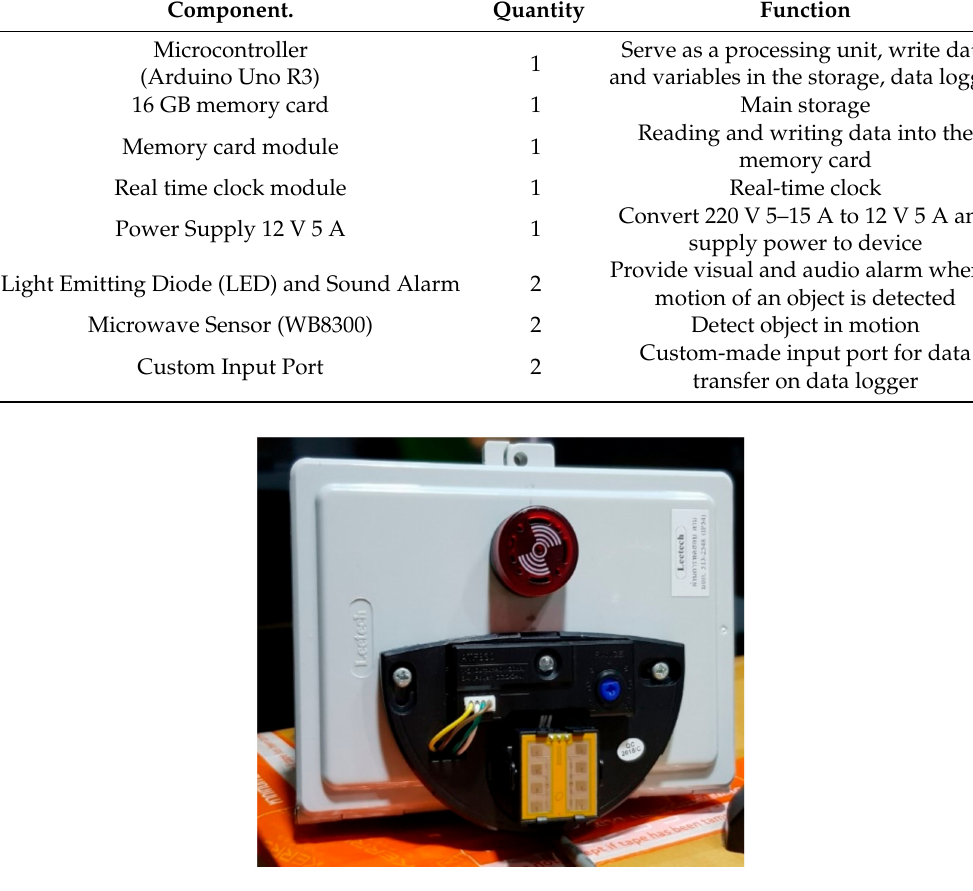
Figure 1. Microwave